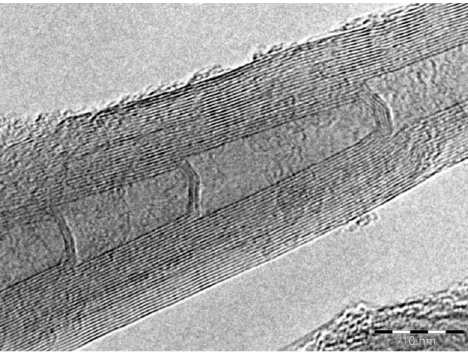
Figure 2. A Transmission Electron Microscopy (TEM) image of the produced carbon nanofibers (CNFs), showing the interactions of the inner sidewalls.